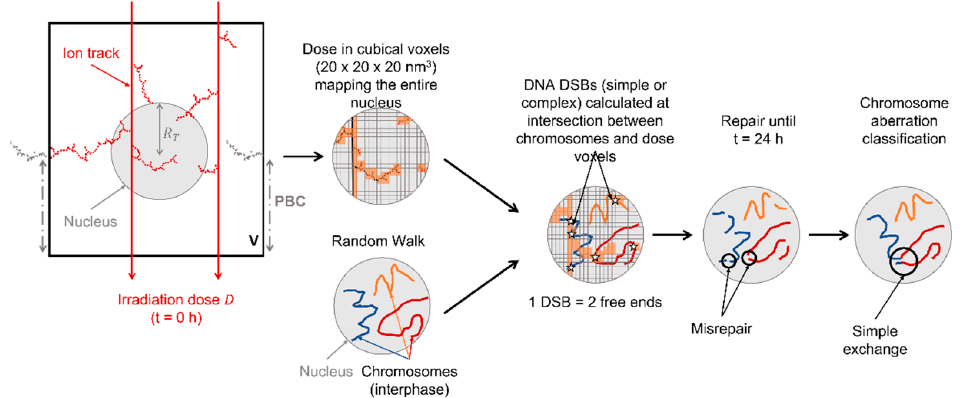
Figure 15. Two-dimensional representation of the different steps in RITRACKS/RITCARD for chromosome aberration calculations. DNA DSBs are defined as simple or complex based on an energy threshold cutoff of 500 eV within a given nanometric voxel. In our model, we assume that only complex DSBs can lead to misrepair. PBC: periodic boundary condition.